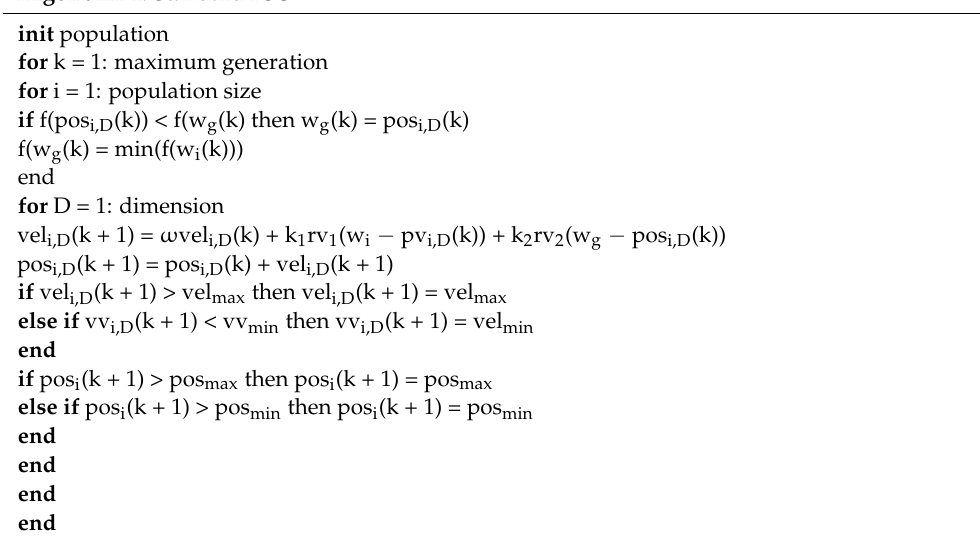
Algorithm 1: Standard PSO.